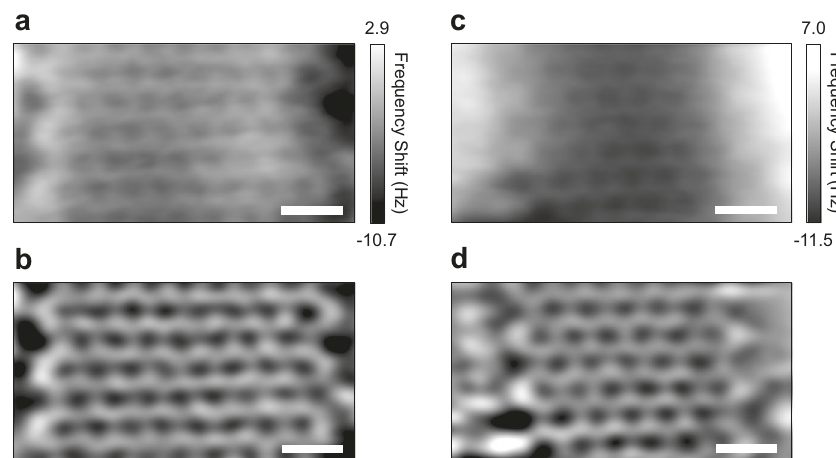
Fig. 4 nc-AFM characterization of 17- and 13-AGNRs. a Constant-height frequency shift image of single 17-AGNR measured by nc-AFM with a CO- functionalized tip. b Laplace- fi ltered image of a . c Analogous frequency shift image of single 13-AGNR and d Laplace- fi ltered image of c . Frequency shift images were taken at V s = 0 V, oscillation amplitude of 0.10 nm and 5 K. All scale bars, 0.5 nm.